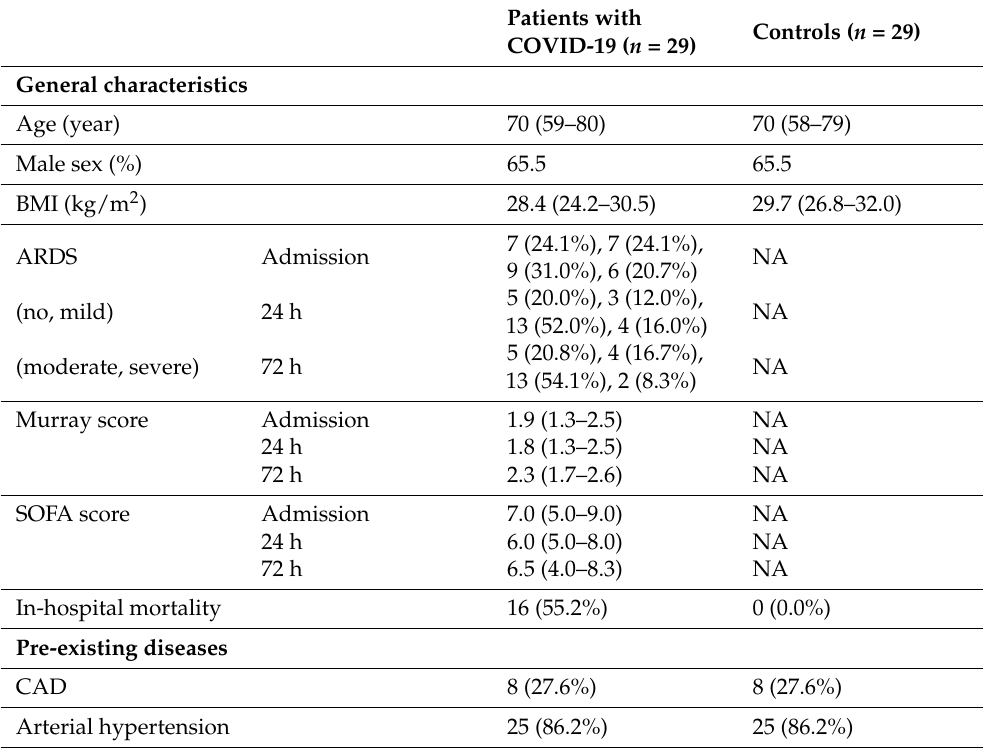
Table 1. Description of the study cohorts. Since some patients deceased or were transferred to the ward, the analysis consists of 29 (t 0 ), 25 (t 24 ) and 24 (t 72 ) patients, respectively. Furthermore, 3 patients received no anticoagulation at t 72